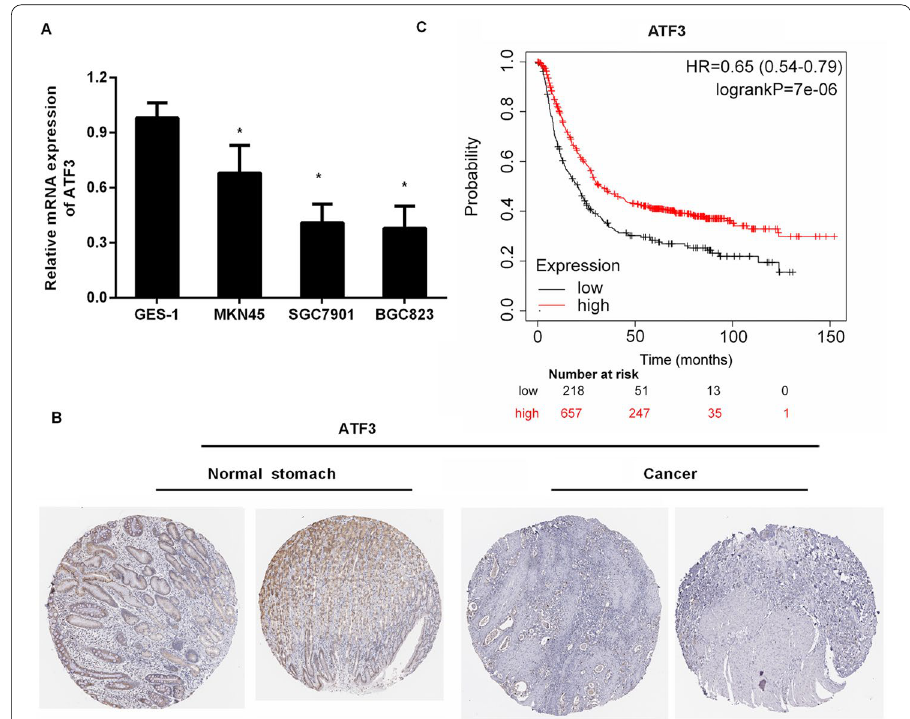
Fig. 1 ATF3 expression and prognosis in gastric cancer cells and tissues. A Transcription of ATF3 in human gastric epithelial cell GES-1 and GC cell lines (MNK45, SGC7901 and BGC823). B ATF3 protein expression in normal stomach and GC tissues. Images were obtained from the Human Protein Atlas online database. C Kaplan–Meier plotter analysis evaluated ATF3 expression and overall survival in GC patients. * P <